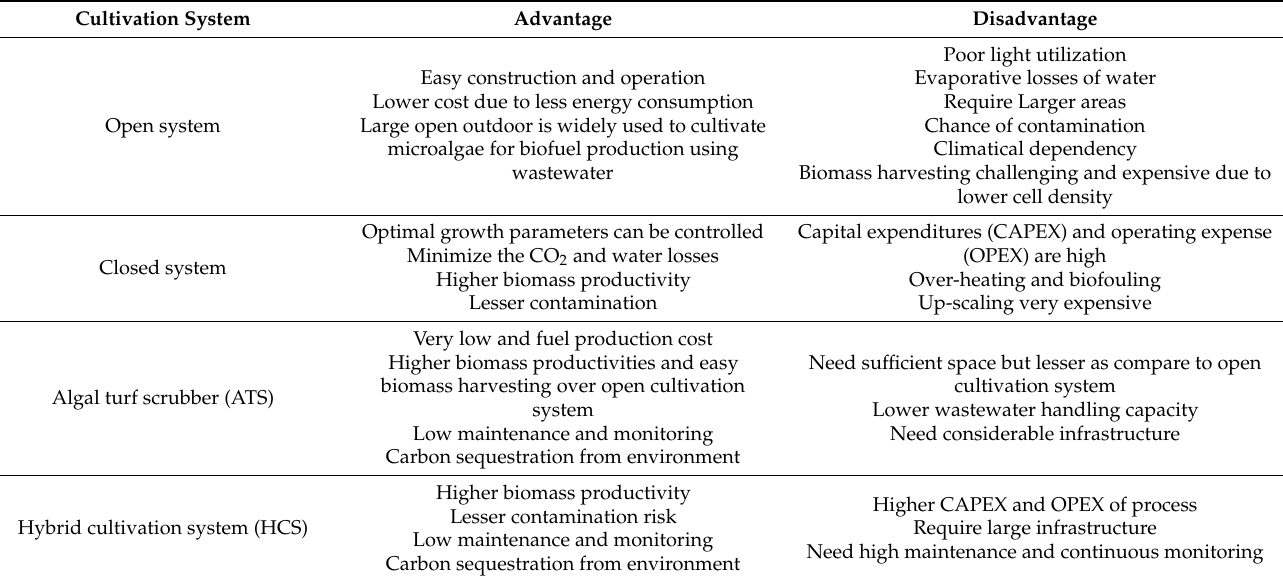
Table 2. The main benefits and drawbacks of different microalgae cultivation systems. Cultivation